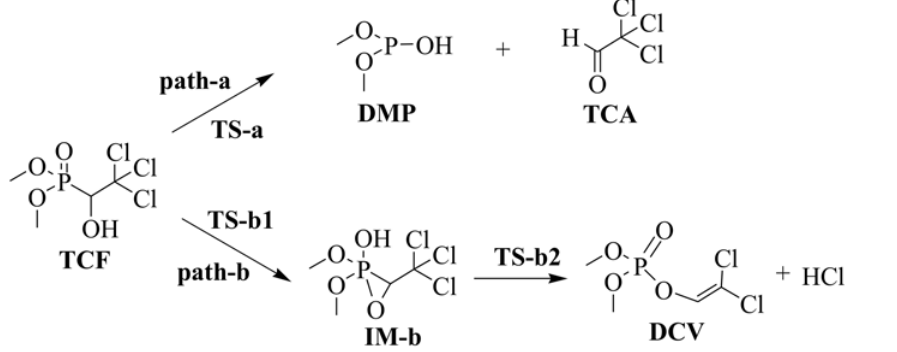
Fig 3. The proposed pyrolysis pathways of